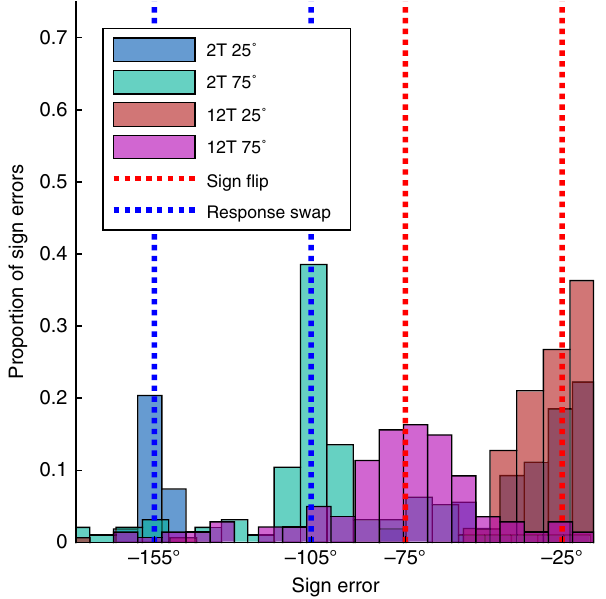
Fig. 3 Sign error analysis. Histograms of pooled “ sign error ” data in each group. Vertical dotted lines represent predicted locations of “ swap ” errors (generating the wrong response given two choices) and “ fl ip ” errors (reaching relative to the correct magnitude of rotation but the wrong